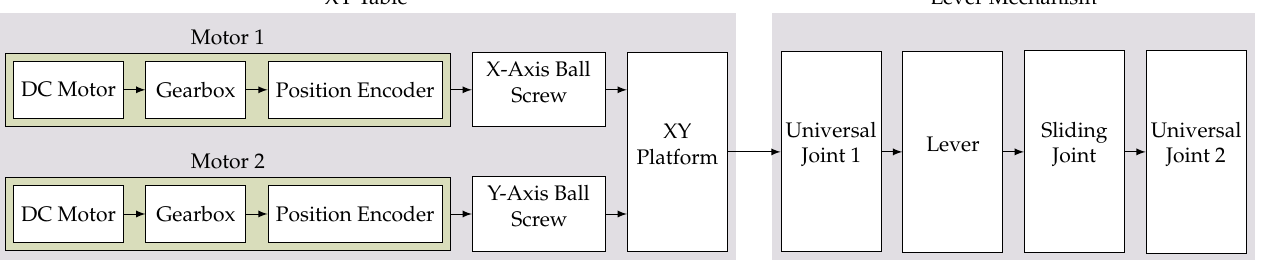
Figure 7. Block diagram visualization of the kinematic chain of the proposed mechanism, highlighting mechanical components inside the servo motors as well as the two subsystems, the XY-Table as well as the lever